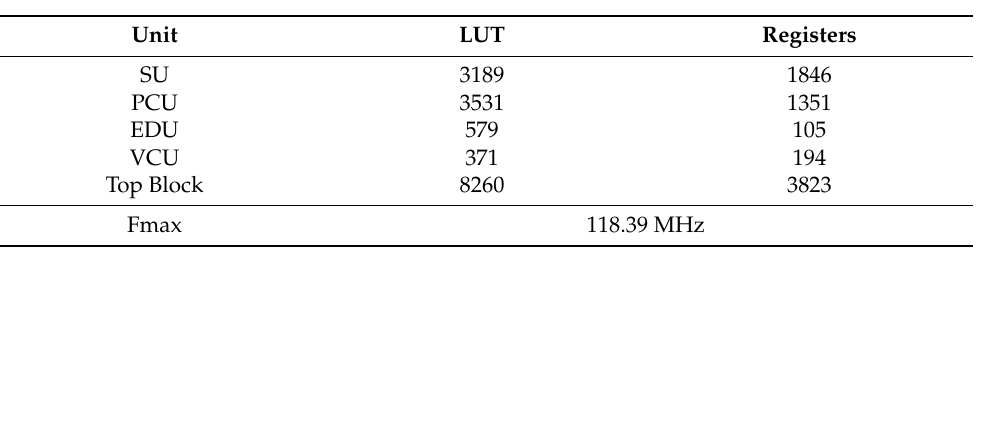
Table 3. Logic synthesis results of proposed CFAR targeting Stratix II ( N =